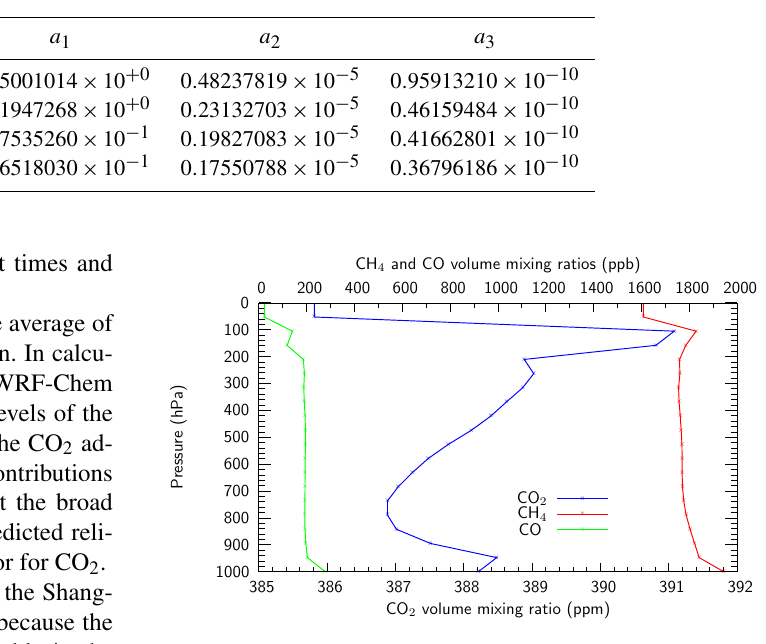
Figure 5. Prior vertical profiles for volume mixing ratios of CO 2 , CH 4 and